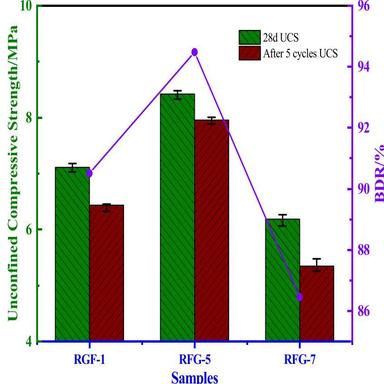
Freeze-thaw cycle test results.